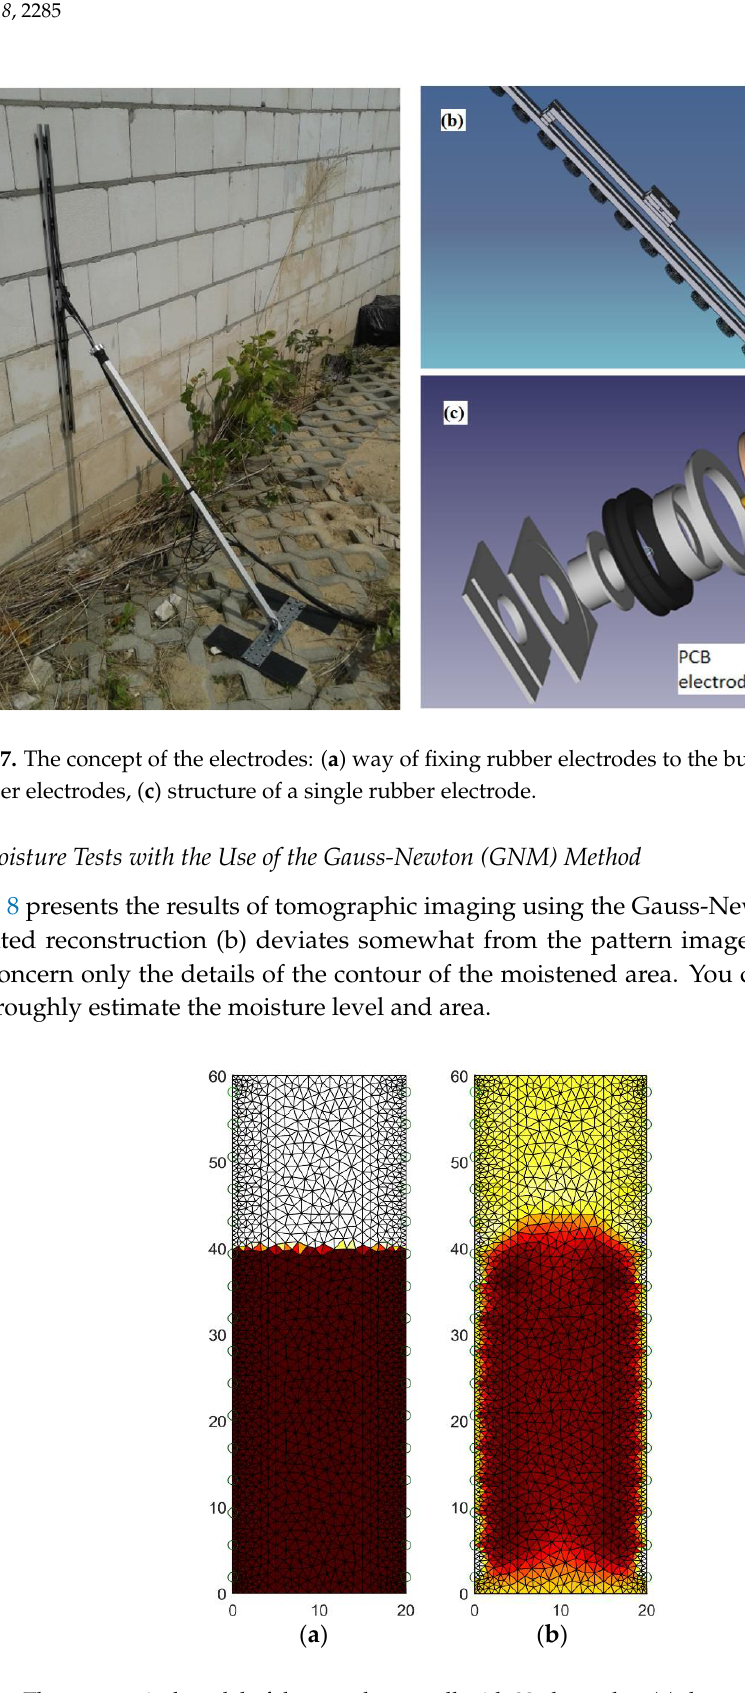
Figure 8. The geometrical model of the tested wet wall with 32 electrodes: ( a ) the pattern image, ( b ) the image reconstructed by Gauss-Newton method.